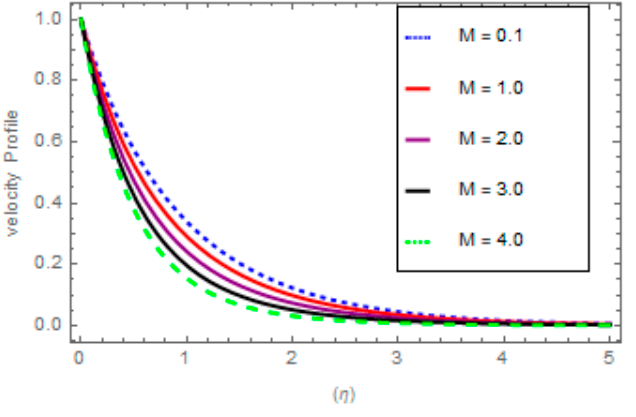
( ) ' u η ( ) ( ) ( η ) . ' 0 ' u η u η . 0 0 0 . .